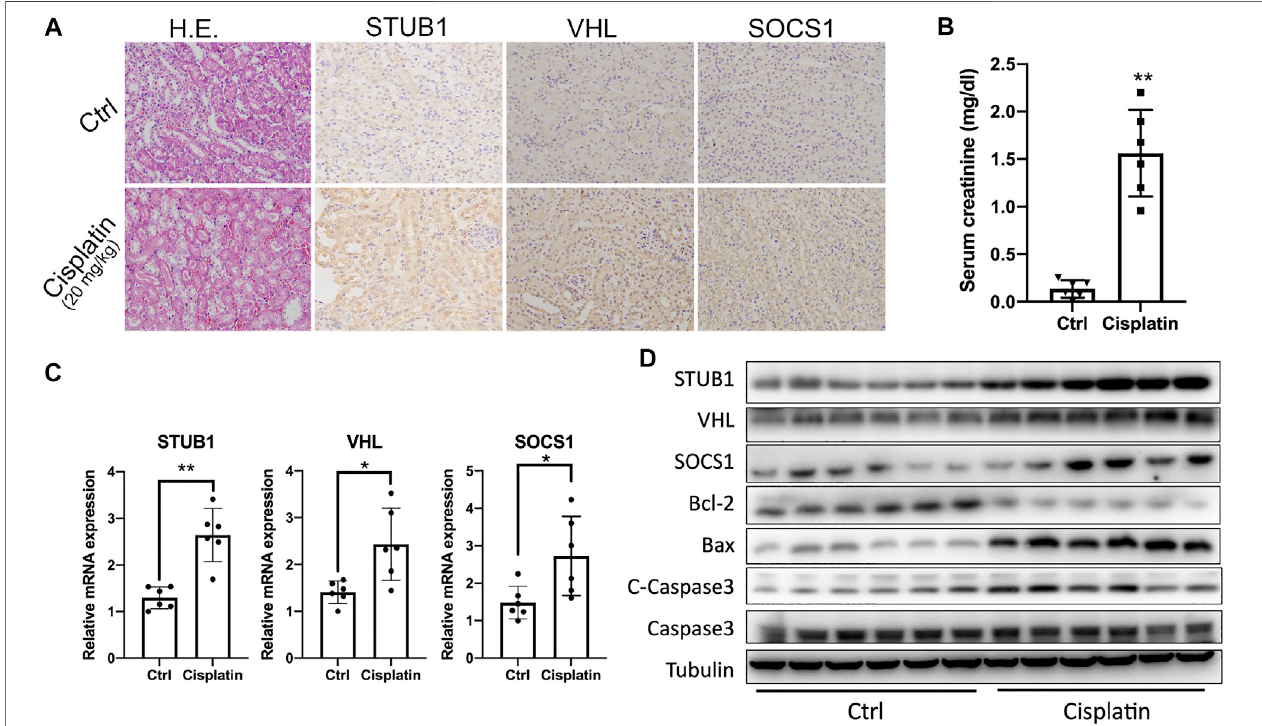
FIGURE 7 | Validation of the upregulated hub genes in the cisplatin-induced AKI mouse model. (A) HE and IHC staining of the kidneys from mice treated with control and 20 mg/kg cisplatin. Magni fi cation × 200. (B) Serum creatinine levels from mice treated with control and 20 mg/kg cisplatin ( n (cid:2) 6). * p < 0.05, ** p < 0.01, comparedtocontrol. (C) qPCRofSTUB1,VHL,andSOCS1mRNAlevelsinmicetreatedwithcontroland20 mg/kgcisplatin( n (cid:2) 6).* p < 0.05,comparedtocontrol.ns, no signi fi cance. (D) Western blot of STUB1, VHL, and SOCS1 and apoptosis proteins in mice treated with control and 20 mg/kg cisplatin ( n (cid:2) 6).